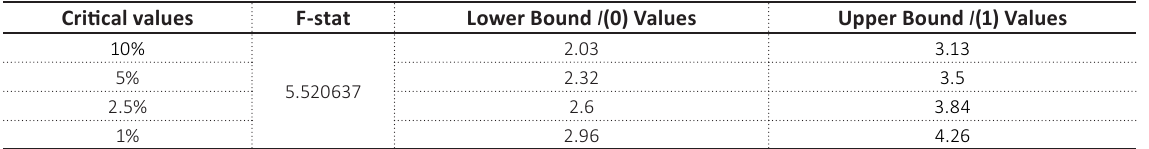
Table 3. Bounds cointegration test result